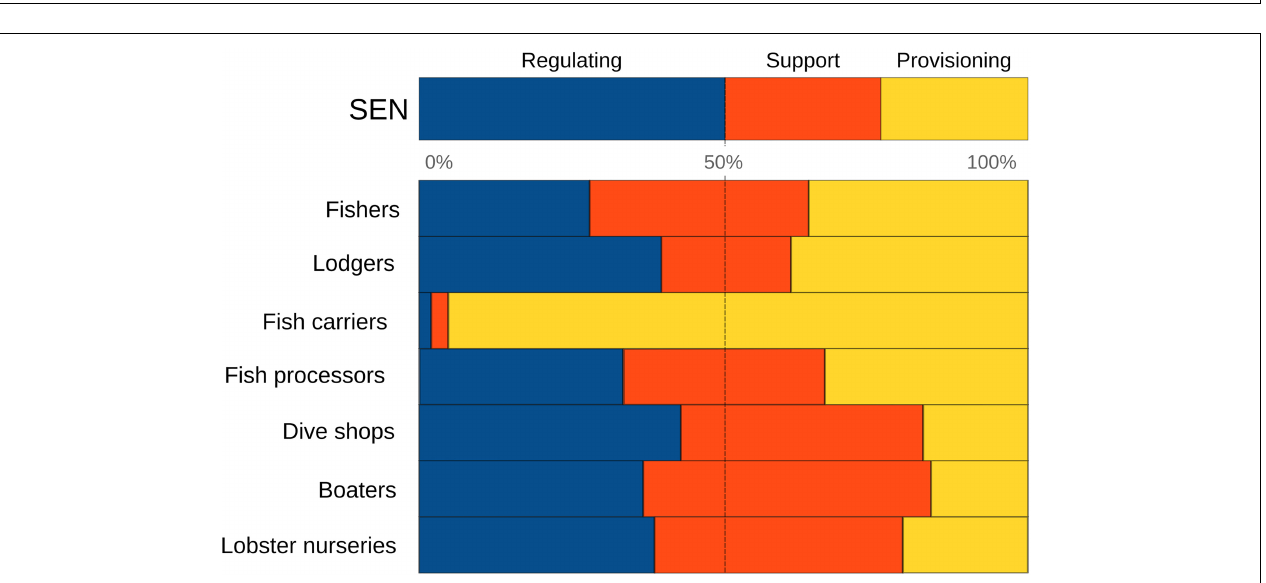
FIGURE 3 | Socio Ecological Network representing the flow of economic benefits through stakeholders in Los Roques National Park during 2014 and derived from ecosystem services through fisheries and tourism. The size of nodes represents its value of intermediation centrality.